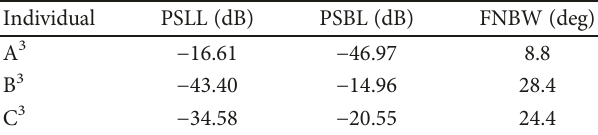
Figure 7: The Pareto front for case 3. Table 6: Performances of three individuals in case 3.